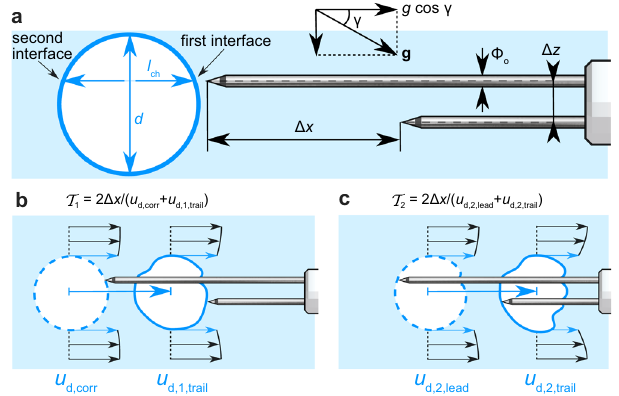
Fig. 3 Bubble – probe interaction phases. a Undisturbed bubble approaches a double-tip phase-detection probe. b Piercing and travel time of the fi rst interface. c Piercing and travel time of the second interface.